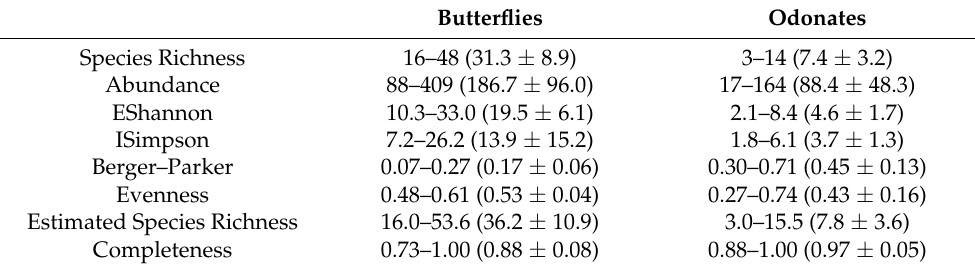
Table 1. Alpha diversity metrics (range and mean ± SD) for the two insect groups across study sites. Species Richness: observed species richness, EShannon: exponential of Shannon diversity index, ISimpson: reciprocal of Simpson’s diversity index, Berger–Parker: reciprocal of Berger–Parker index, Estimated Species Richness: estimated species richness using